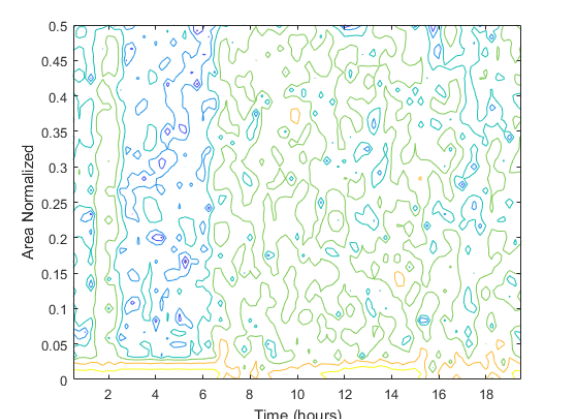
Figure 7. Example of testing the safety limits of operation of the park. Contour plot, blue colour denotes lowest values. The maximum value (red) corresponds to a 90–100% power extraction, while the lowest value (blue) corresponds to 0–10% power extraction.